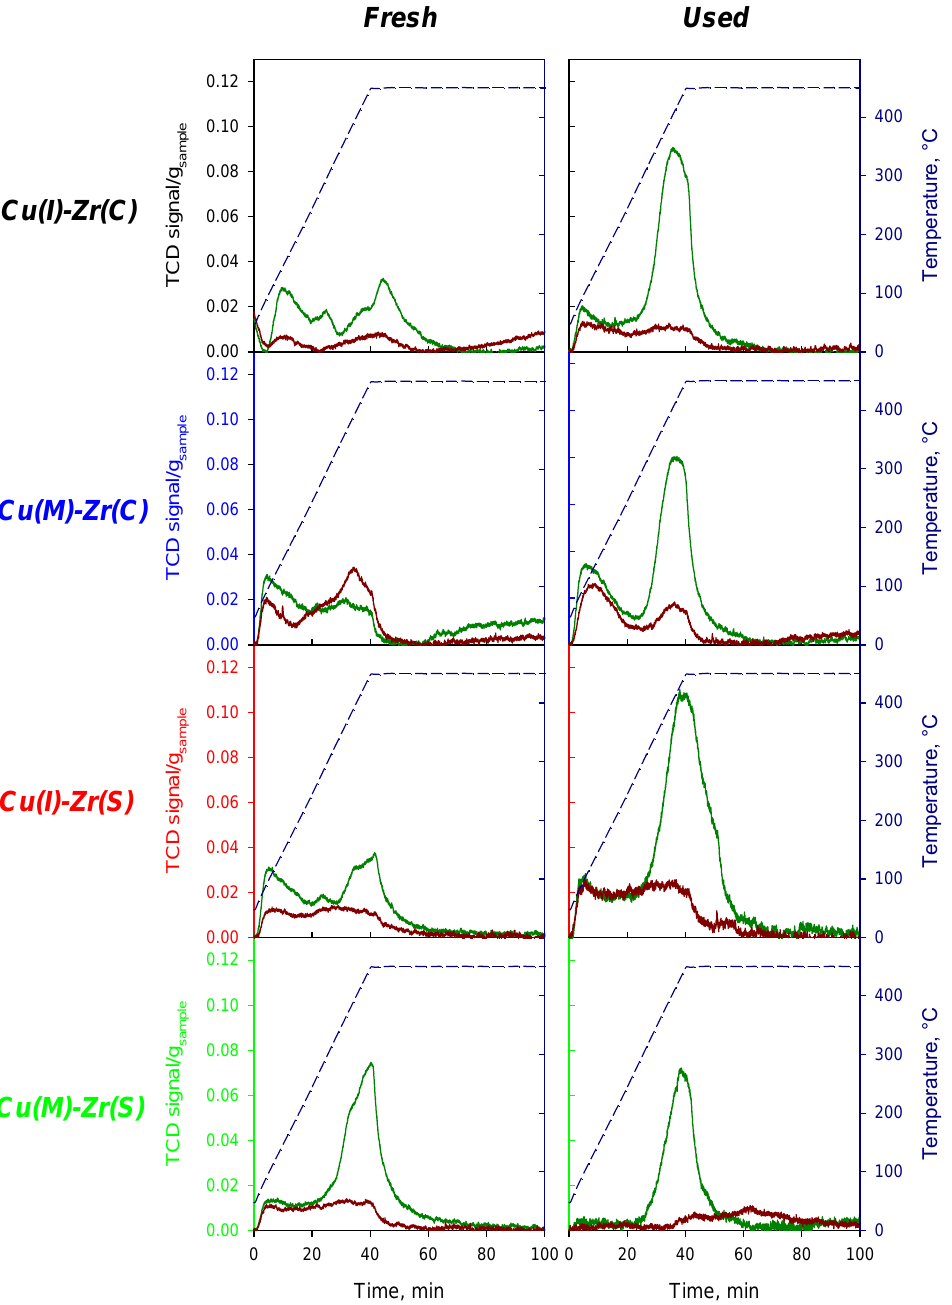
Figure 5. Profiles of NH 3 -TPD tests over fresh and used samples before (dark green lines) and after (dark red lines) H 2 -TPR tests.